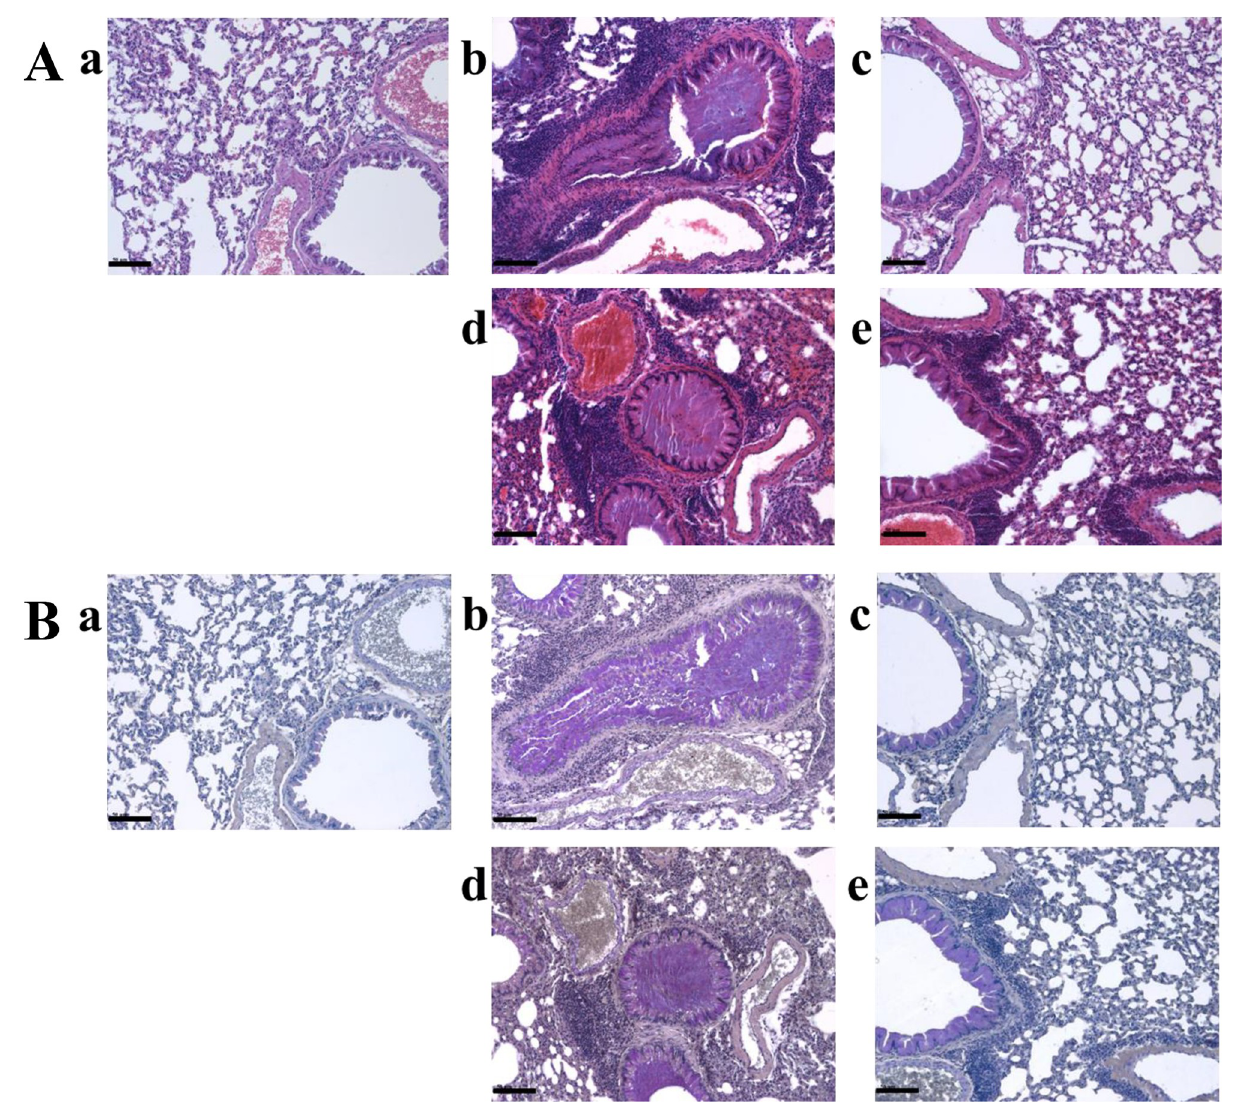
Fig 4. Macmoondongtang dose-dependently inhibited typical morphological changes in the lungs of mice with OVA-induced asthma. (A) Macmoondongtang controlled base membrane thickening caused by epithelial cell hyperplasia, inflammatory infiltration near bronchiole and vessel, mucous hypersecretion, and other changes based on H&E staining. (B) Macmoondongtang dose-dependently suppressed mucous secretion based on PAS staining. a , vehicle control; b , asthma induction; c , dexamethasone; d ,150 mg/kg/day macmoondongtang ; e , 1500 mg/kg/day macmoondongtang . Br, bronchioalveolar region; V, vessel. Scale Bar = 50 μ m. Magnification, × 200.